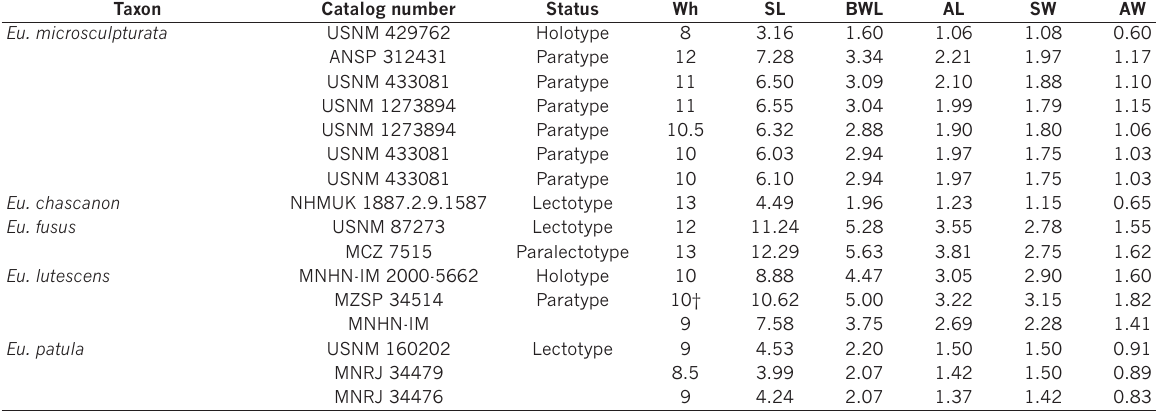
Table 1. Measurements (in mm, except for number of whorls) of Eulimacrostoma species